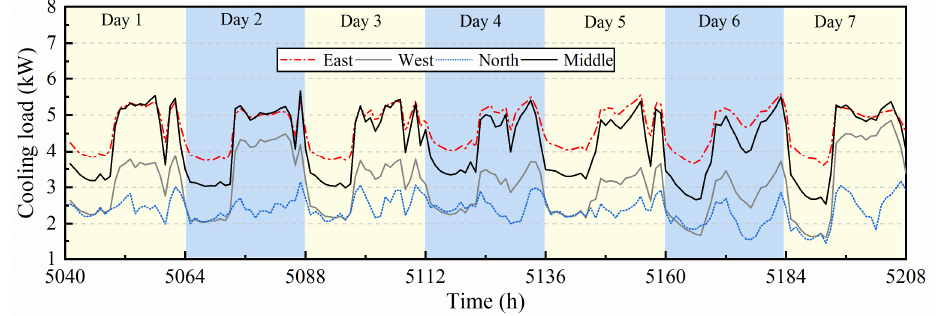
Figure 14. Load profile for the 4 subzones in one week.